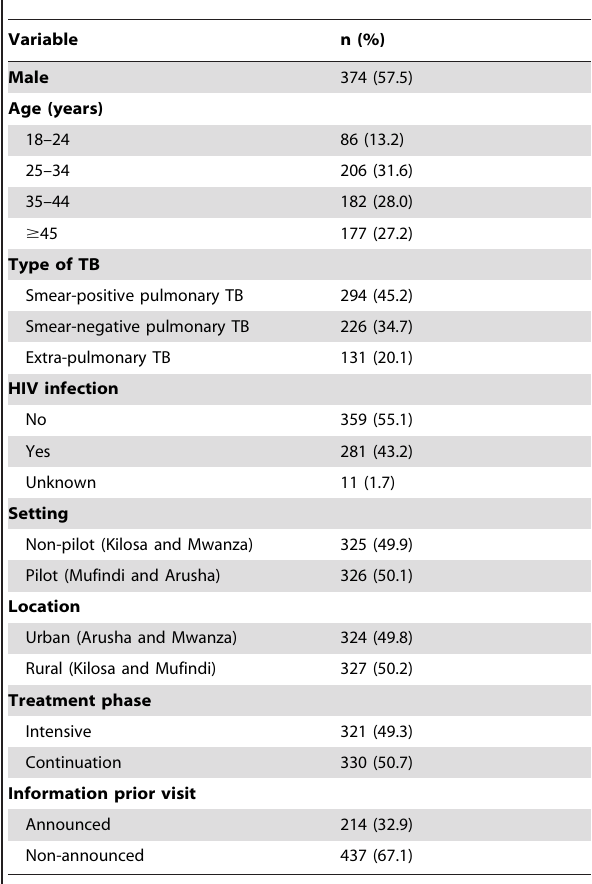
Table 1. Characteristics of enrolled patients (N =651).